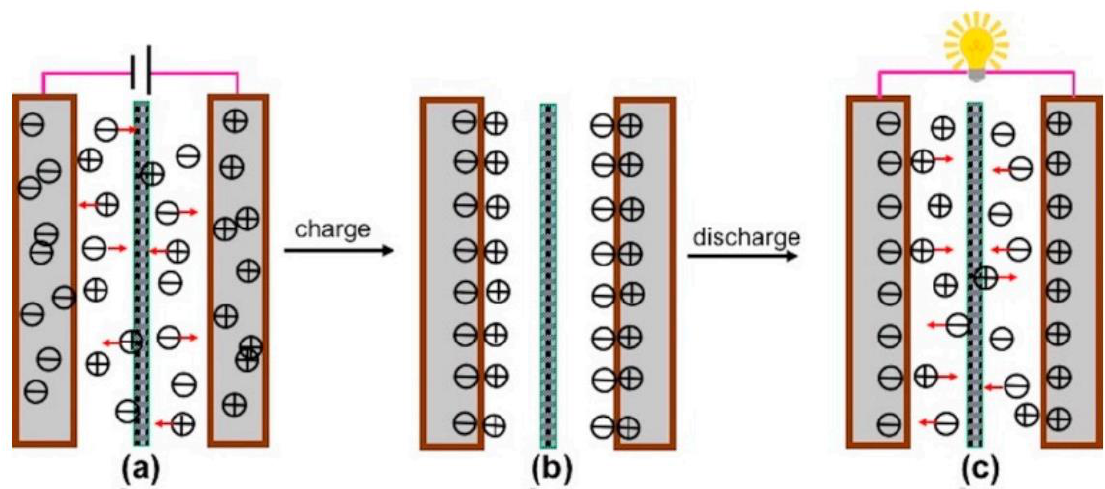
Figure 2. Schematic illustration of the charging process ( a ): charged state ( b ), discharging process ( c ) [26].